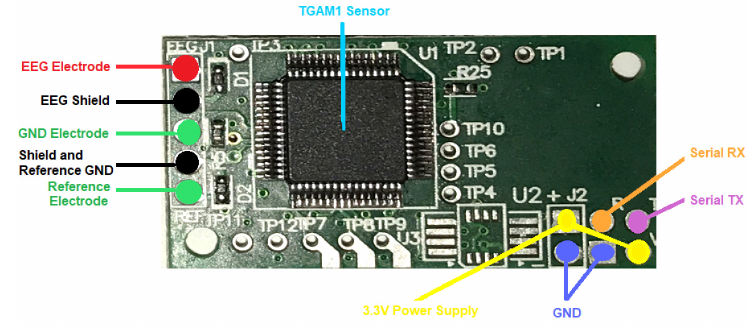
Figure 8. ThinkGear ASIC Module electroencephalographic sensor